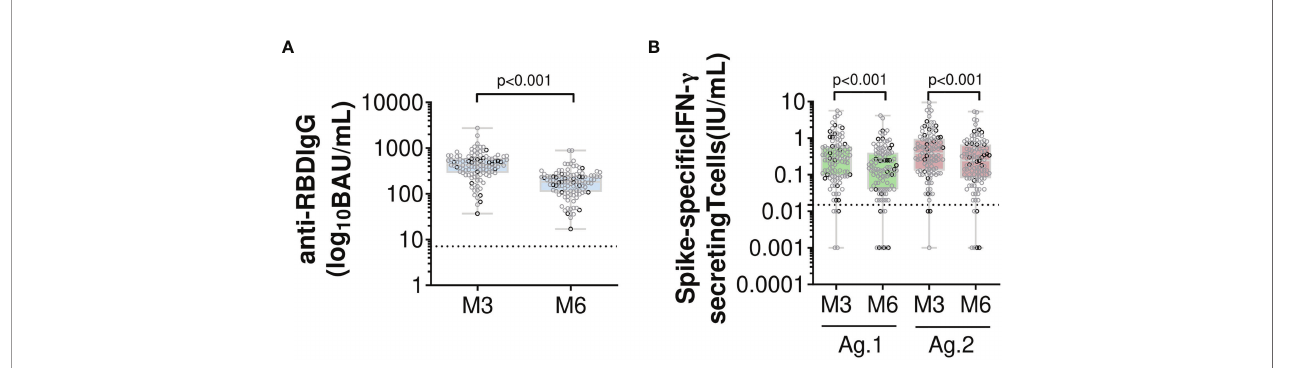
FIGURE 1 | Humoral and speci fi c T-cell responses in 110 healthcare workers 3 and 6 months after the second dose of the BNT162b2 mRNA vaccine. Evolution over time of (A) serum anti-RBD IgG antibodies and (B) IFN- g secreting memory T-cells via an Interferon-Gamma Release Immunoassay that uses two mixes of SARS-CoV-2 spike protein (Ag.1 and Ag.2) selected to activate both CD4+ and CD8+ T-cells. Box and whiskers plot indicate median and interquartile range associated with min to max. All participants are indicated, and sex is discriminated by grey (women) or black (men) circle. Black dotted lines represent respective positive thresholds (p<0.001 versus M3, linear mixed-effects models). Number of cases for each time point (a) M3, 110; M6, 110; (b) M3, 108; M6, 110. BAU, binding antibody unit; IFN- g , interferon gamma; IU, international unit; M3, 3 months post complete vaccination; M6, 6 months post complete vaccination; RBD, receptor-binding domain.